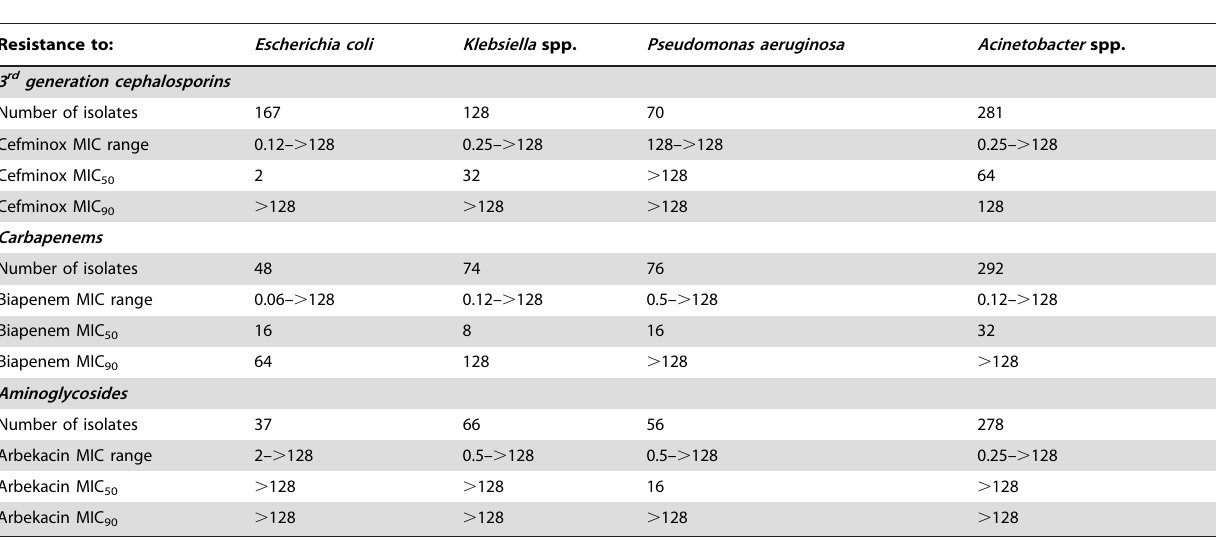
Table 6. Resistance profile of the included isolates to the study drugs.